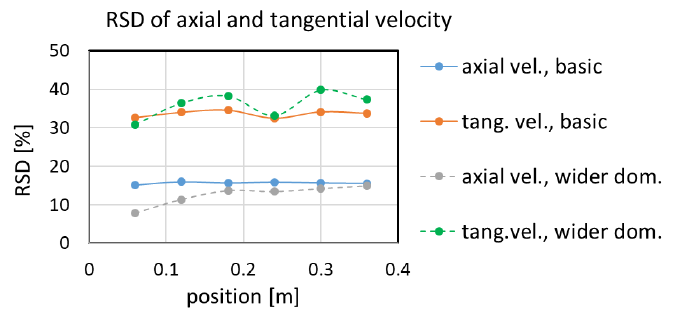
Figure 9. Relative standard deviations of axial and tangential velocities at six points along the air gap in the cases of the basic and doubled domains.